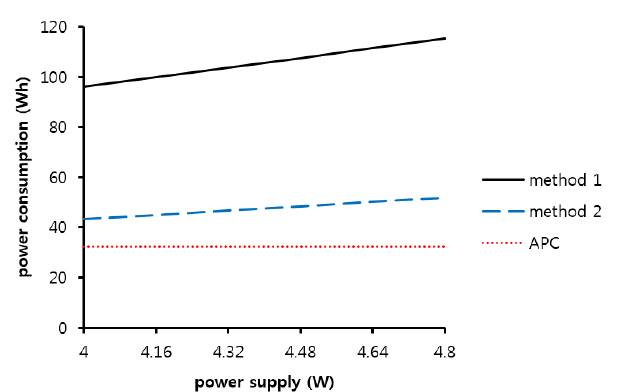
Figure 8. Power supply vs. power